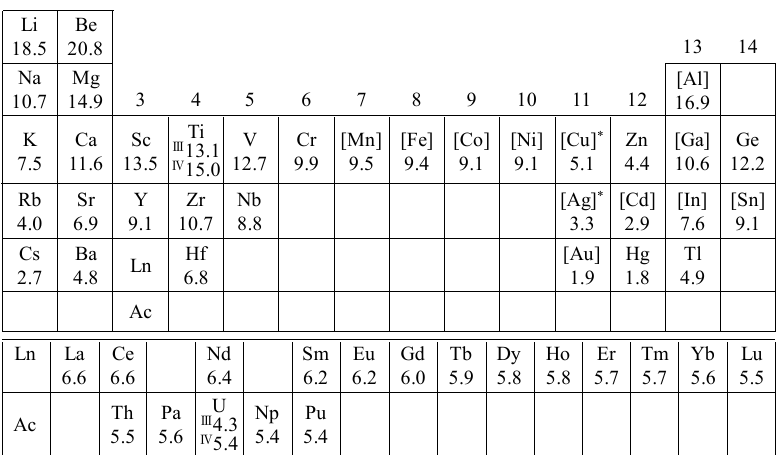
) [3]. Reproduced with 4 n